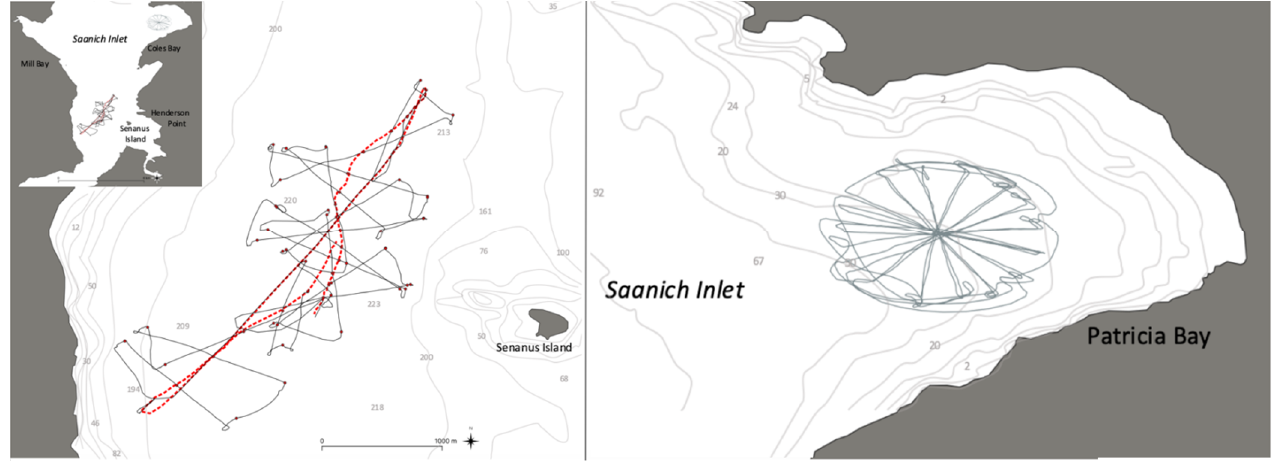
Figure 3. ( Left ): Deep-water survey tracks of the source (black line) and recording vessels (dotted red line); ( Right ): transects of the source vessel in shallow water around the anchored recording vessel in the middle of the transect circle.